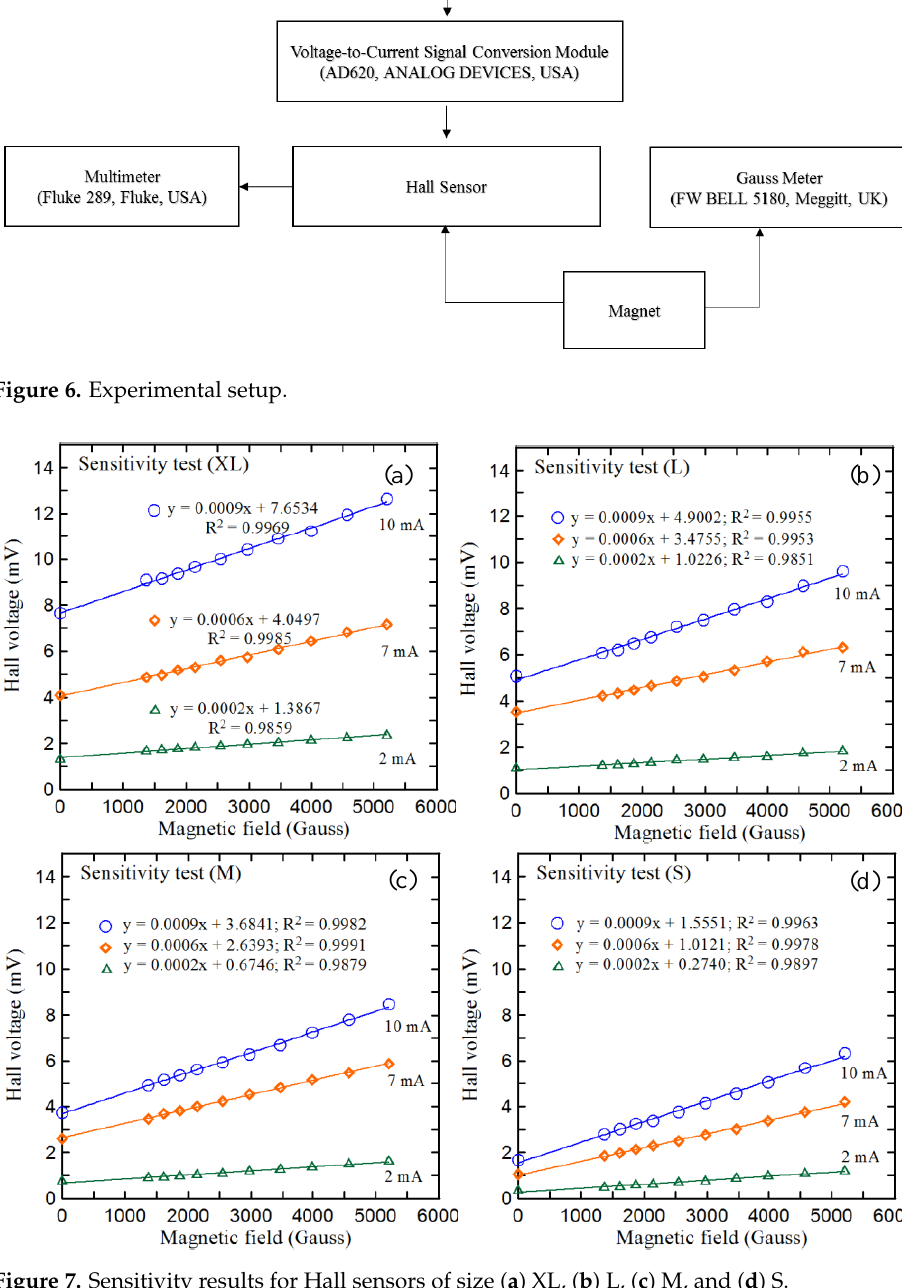
Figure 7. Sensitivity results for Hall sensors of size ( a ) XL, ( b ) L, ( c ) M, and ( d ) S.